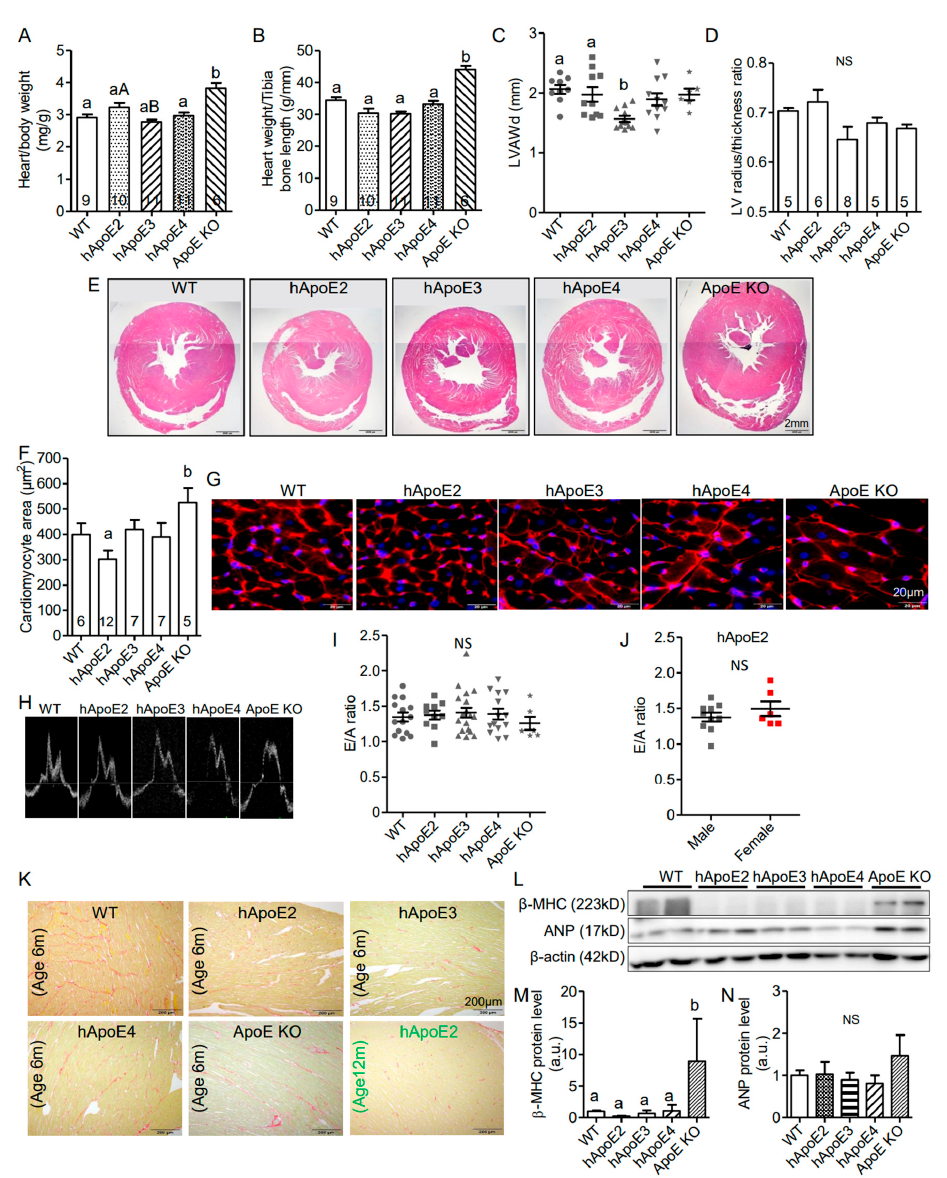
Figure 2. Multiple tests demonstrated that hApoE2 rats did not exhibit detrimental heart remodeling. ( A , B ) Heart weight normalized by body weight ( A ) and tibia bone length ( B ) were compared between different rats. ( C ) Left ventricular end-diastolic anterior wall thickness (LVAWd) measured at postnatal age 6 months were compared. ( D ) Left ventricular heart wall thickness represented by the ratio of the left ventricular radius and wall thickness was compared via analysis of the Hematoxylin and eosin (HE)-stained cross-sections of the hearts. ( E ) Representative HE- stained cross-sections of the rat hearts were shown. ( F ) Average cell area of cardiomyocytes from cross-sectioned rat hearts was compared. ( G ). Cell membranes of cross-sectioned rat cardiomyocytes were stained by CF555 wheat germ agglutinin (WGA) conjugates in red. Nuclei were stained by DAPI in blue. ( H ) Representative tracings for pulse wave Doppler for the rat mitral annulus velocity were shown. E and A wave ratio, as a marker of the left ventricular diastolic function and stiffness, were compared in different male rats at postnatal 6 months ( I ) and between male and female hApoE2 rats at postnatal 6 months ( J ). ( K ) Images of Picrosirius red staining were